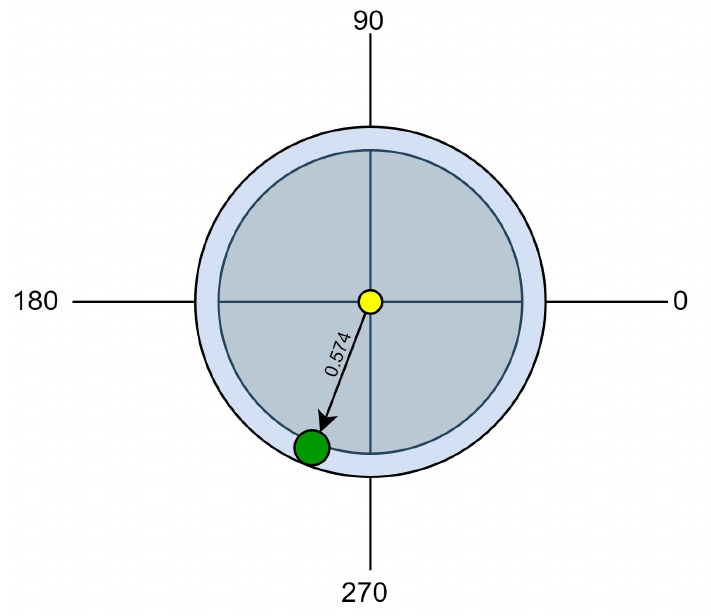
Figure 7. The direction and the magnitude of the resultant net force